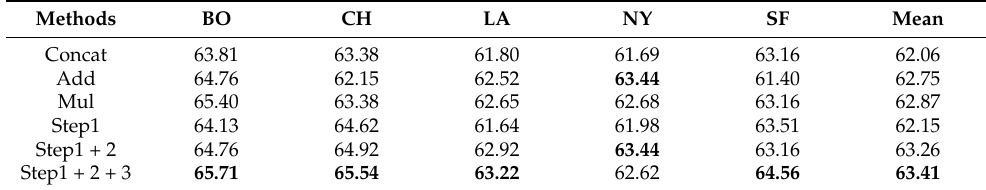
Table 8. Performance comparison of the representation fusion methods on classification